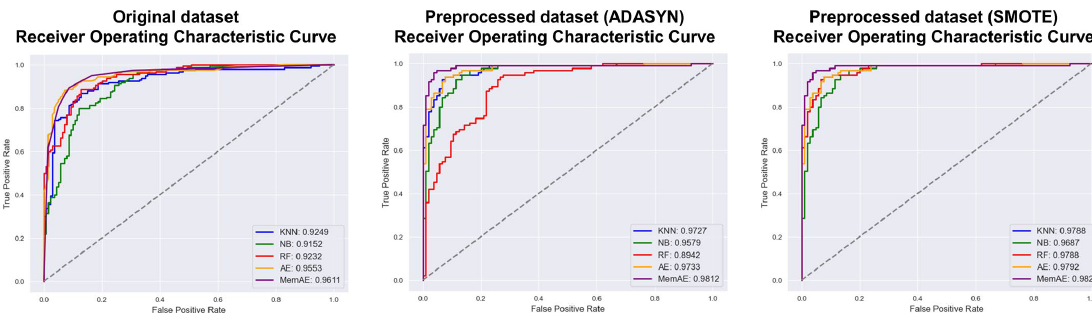
Figure 8. ROC Curve graph of each model. Table 7. Malicious behavior detection results by model using the original dataset.